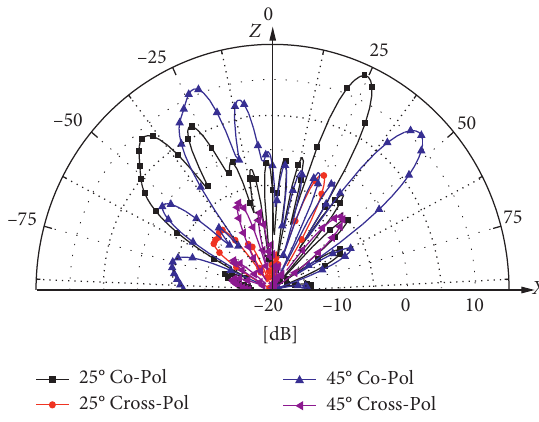
Figure 14: Simulated radiation pattern with the beam steering angles of θ yoz � 15 ° in yoz